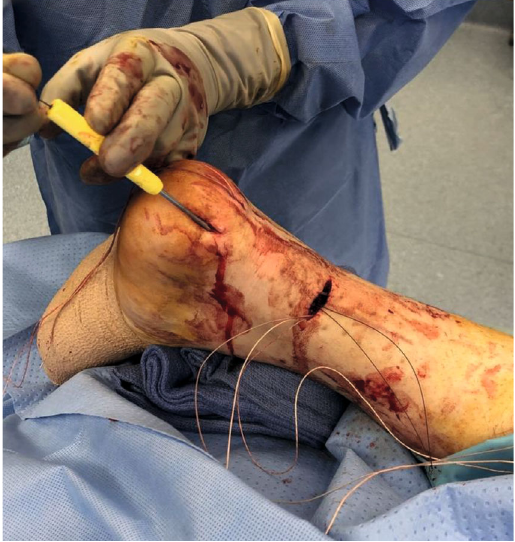
Figure 4: Sutures being passed from proximal Achilles through distal tendon stump with suture lasso to be anchored in the calcaneus.